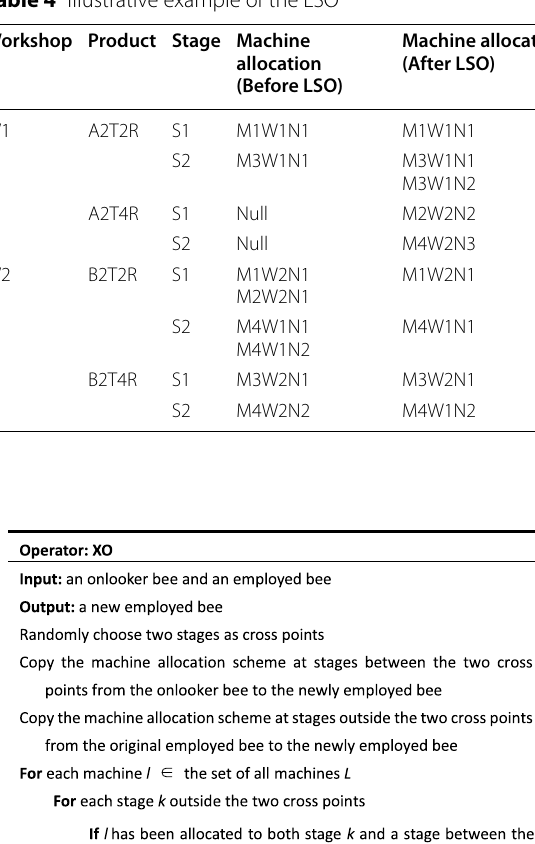
Table 5 Illustrative example of the